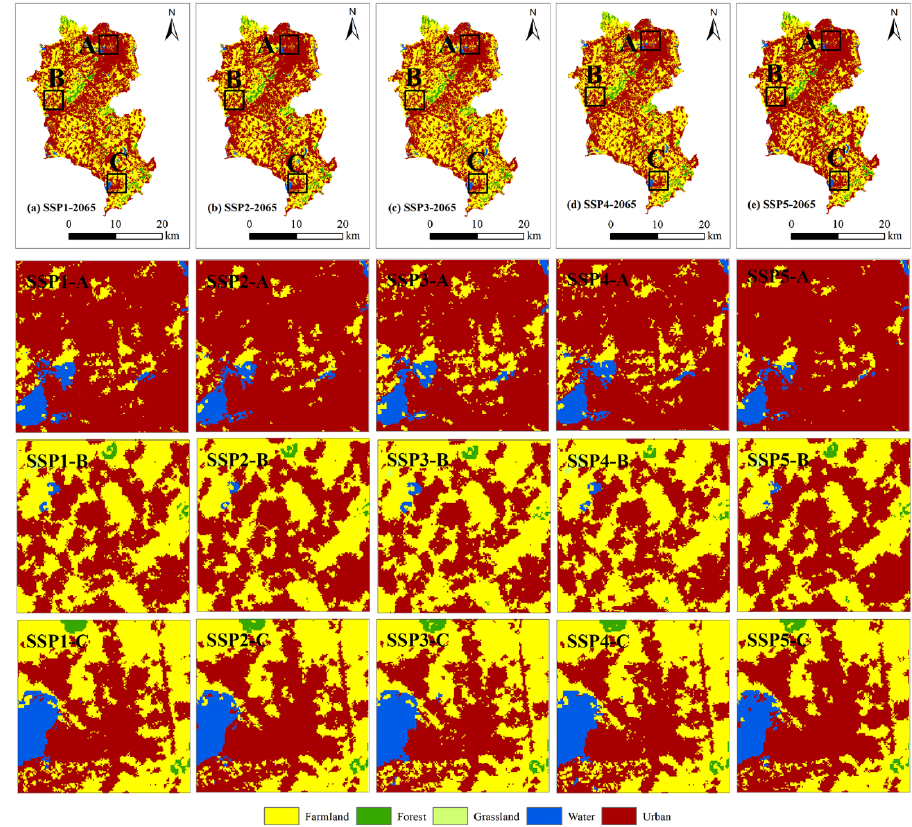
Figure 5. Simulation of LULC changes in Jinjiang City from 2020 to 2065 under five SSP scenarios. Table 4 lists the percent change in the land-use area under the di ff erent SSP scenarios